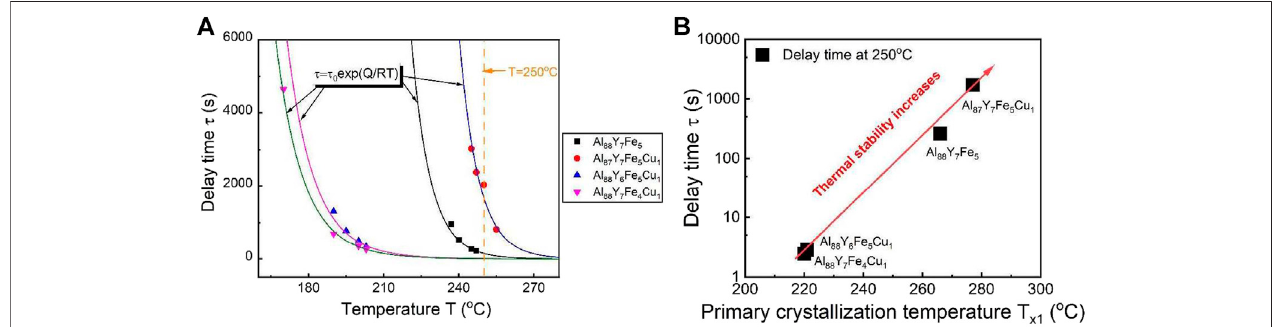
FIGURE 8 | (A) Plot of delay time and temperature for Al 88 Y 7 Fe 5 , Al 87 Y 7 Fe 5 Cu 1 , Al 88 Y 6 Fe 5 Cu 1 , and Al 88 Y 7 Fe 4 Cu 1 . To determine the values of the delay time at 250 ° C for four compositions, one orange dashed line was plotted and the intersections between the orange line and the curves of the delay time and temperature were the delay times. (B) Correlation between the values of delay time at 250 ° C and the primary crystallization temperature for Al 88 Y 7 Fe 5 , Al 87 Y 7 Fe 5 Cu 1 , Al 88 Y 6 Fe 5 Cu 1 , and